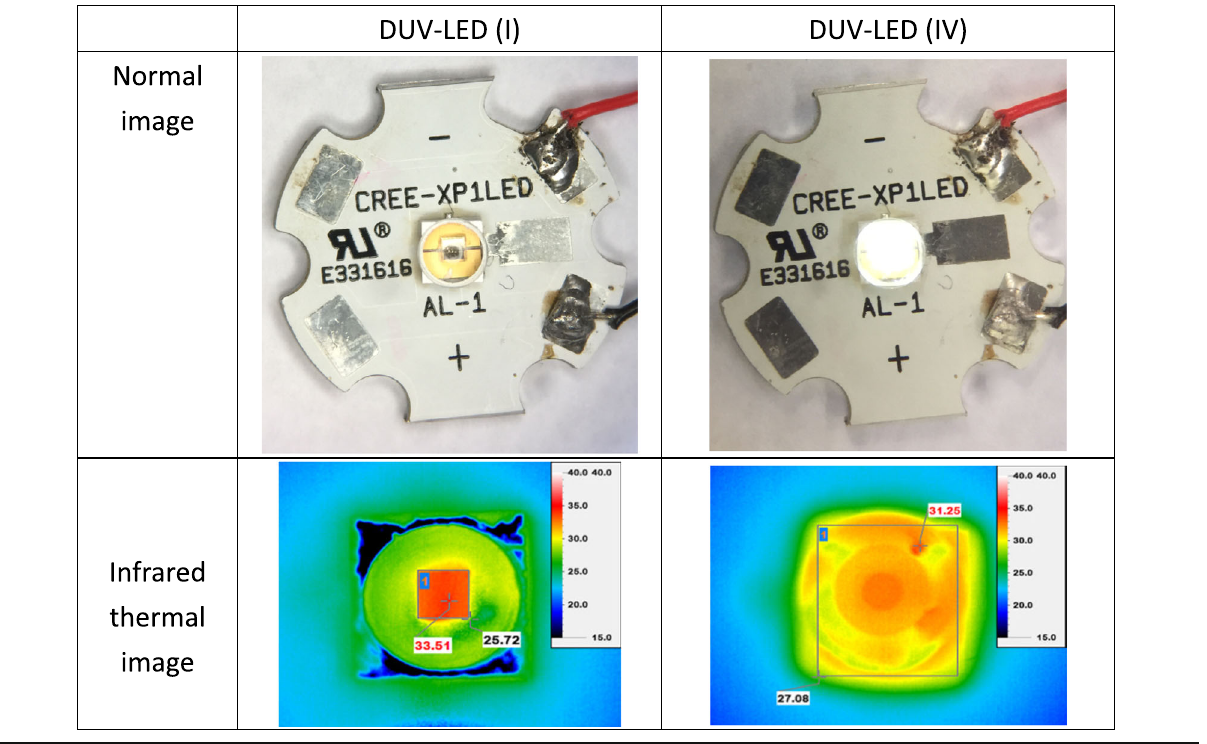
Table 2 Image of DUV-LED (IV) containing PDMS fluid doped with SiO 2 NPs and its operation. Infrared thermal images of (a) the normal